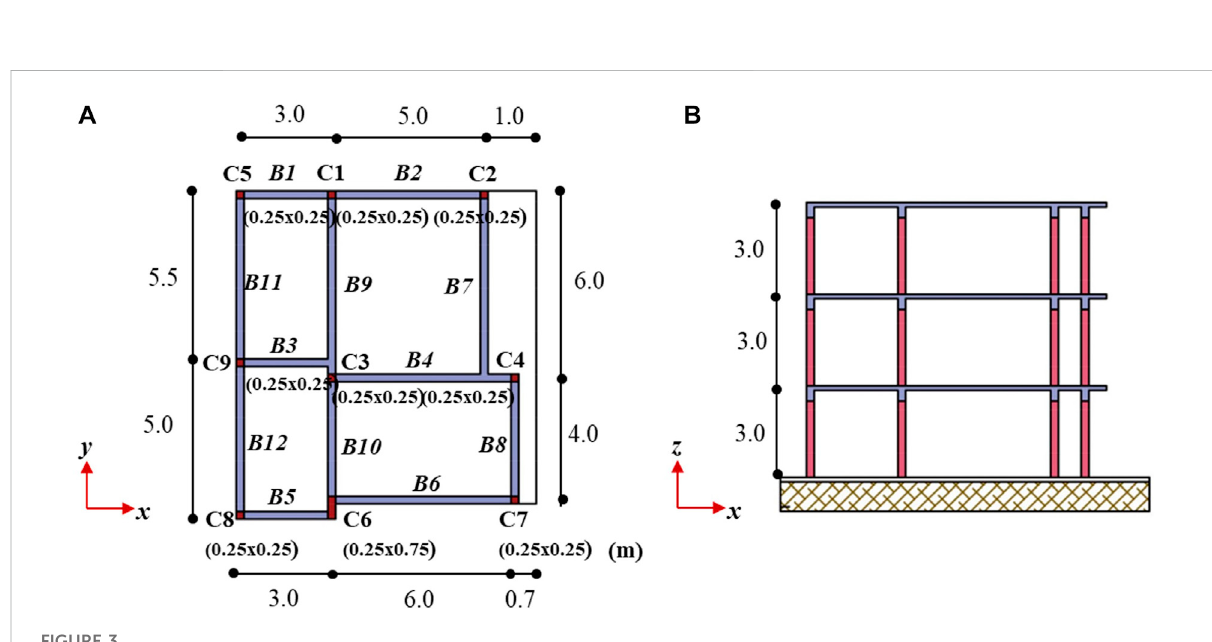
FIGURE 3 (A) Plan and (B)